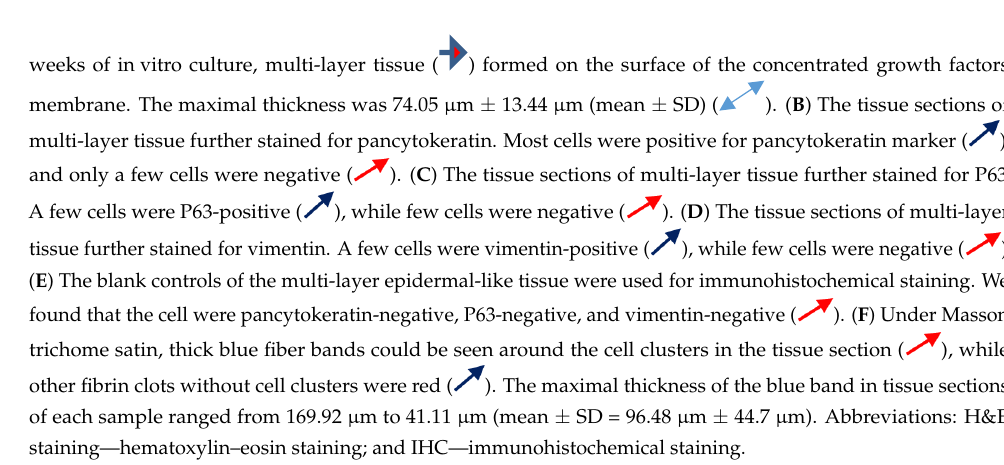
Table 1. Statitical analysis of percentage of cells expressing pancytokeratin, P-63, or vimentin marker in tissue formed by culturing UMST or HaCaT cells on CGF membrane, or UMST on PPP